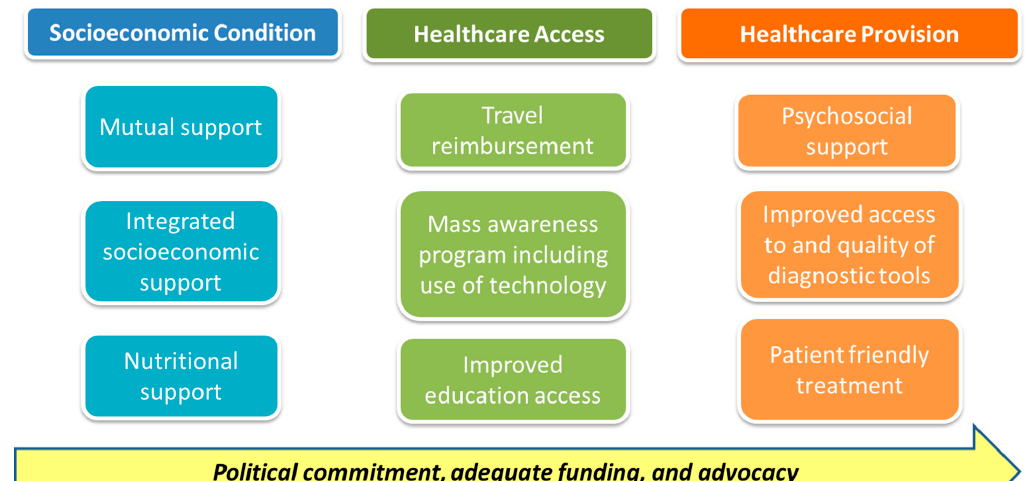
Figure 2. Perceived facilitators to accessing and engaging with TB diagnosis and care.